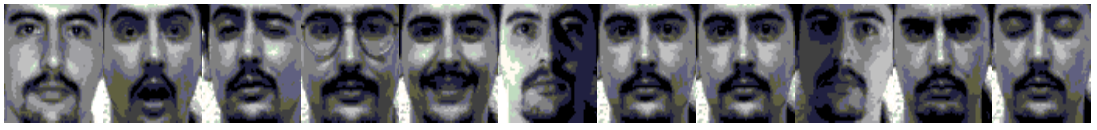
Figure 6. Average recognition rate versus reduce dimensions on CMU PIE dataset. ( a ) l = 10, ( b ) l = 15, ( c ) l = 20, and ( d ) l = 25.